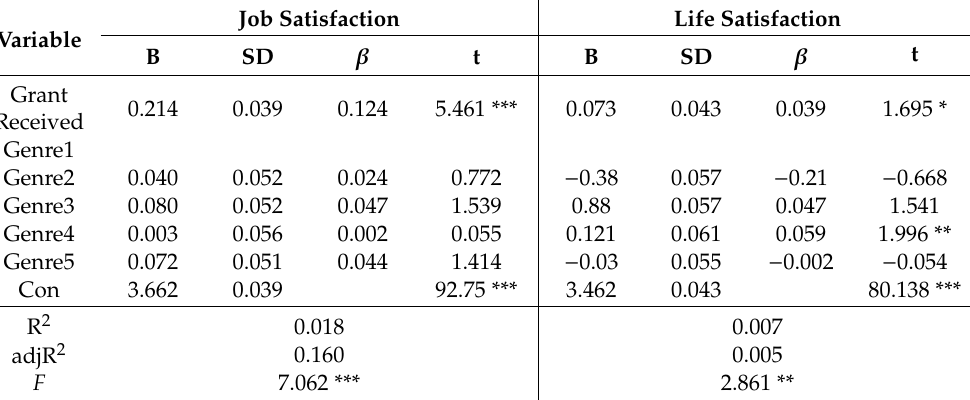
Table 4. Results of regression